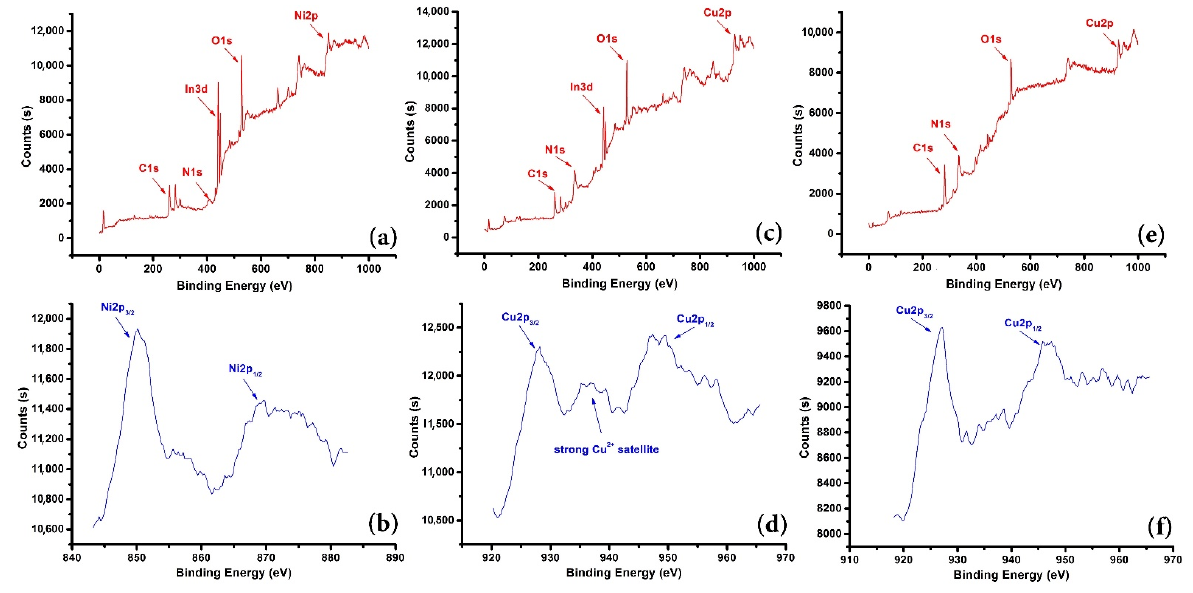
Figure 3. XPS spectra of PASP/NiO ( a ), Ni 2p in PASP/NiO ( b ), Cu/PTRP ( c ), Cu/PNR ( e ), Cu 2p in Cu/PTRP ( d ), Cu 2p in Cu/PNR ( f ). Chemosensors 2022 , 10 , x FOR PEER REVIEW